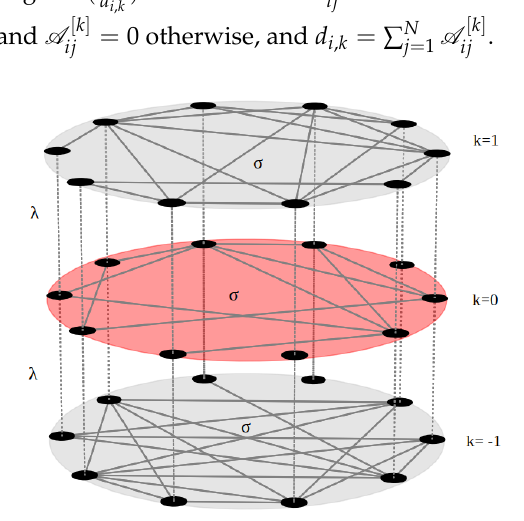
Figure 1. Schematic diagram of a general triplex relay network. The intra-layer coupling with strength σ is presented with solid lines, and inter-layer coupling with strength λ is depicted with dashed lines. The two outer layers ( k = 1, − 1 ) , shown in gray, are connected through the middle layer k = 0, colored in